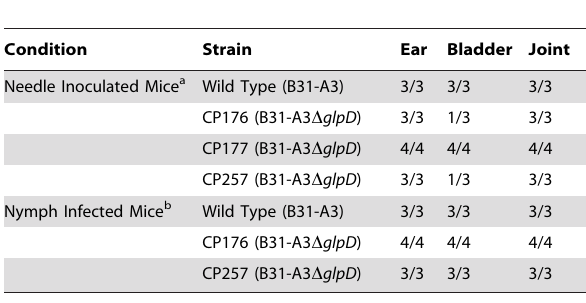
Table represents typical results from 1 of 3 independent experiments. a Wild-type strain B31-A3 or GlpD mutants were needle inoculated into naı¨ve C3H/HeJ mice and tested for infectivity by cultivation of indicated tissue in BSK medium.